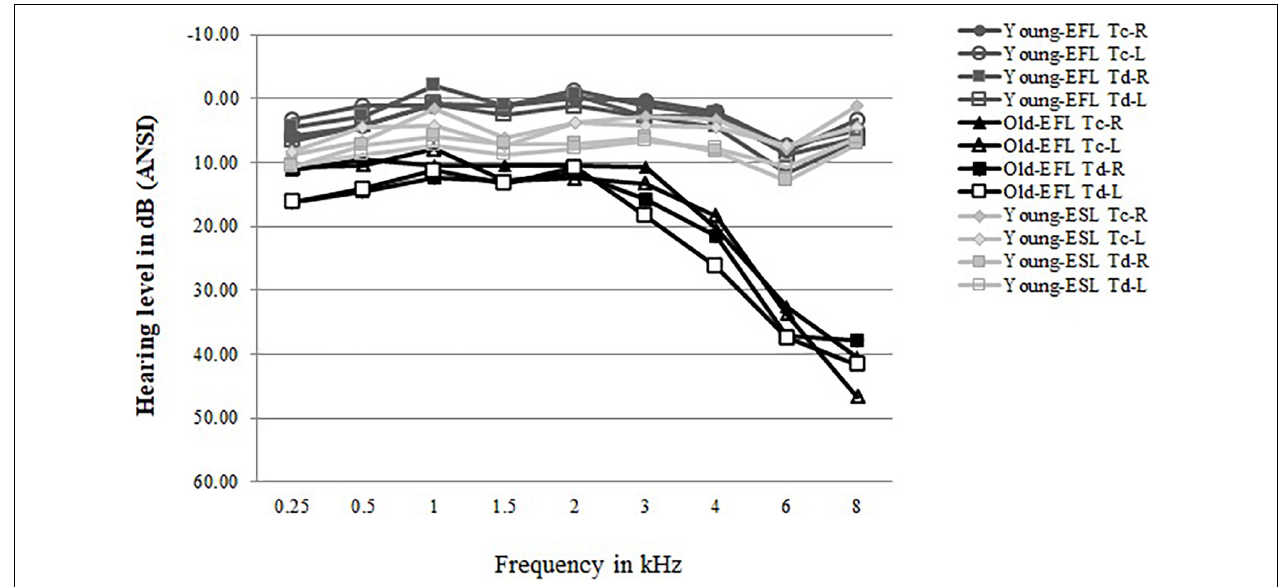
FIGURE 1 | Average audiograms for the two Old-EFL groups (T C vs. T d ) and the two Young-ESL groups (T d vs. T C ) as well as for the equivalent two Young-EFL groups from Avivi-Reich et al. (2020). Left and right ears are plotted separately.